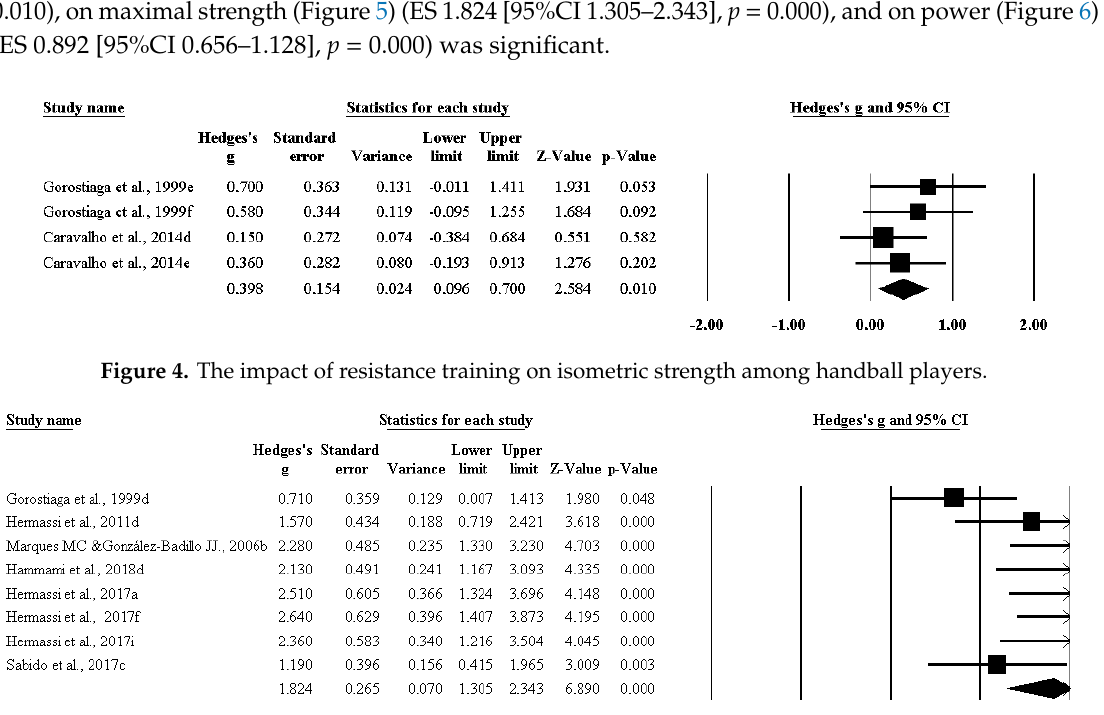
Figure 3. The impact of resistance training on throwing among handball players.